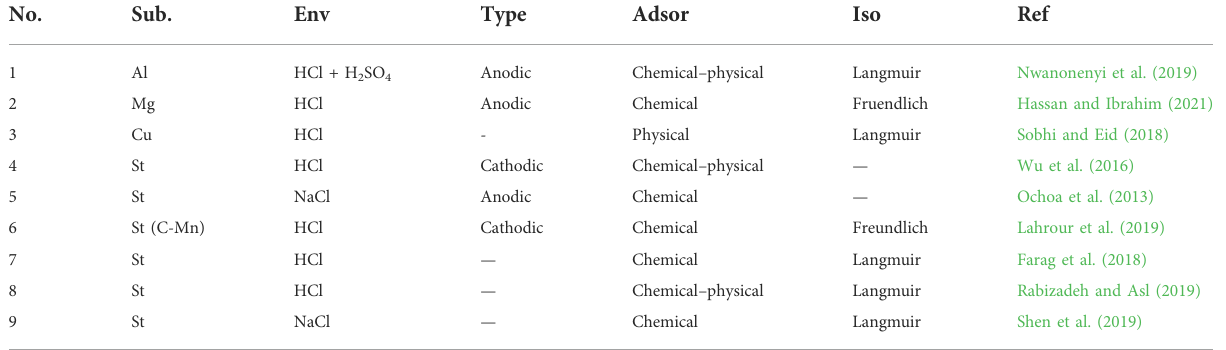
TABLE 1 Data obtained for water-soluble polymer as a corrosion inhibitor. No.